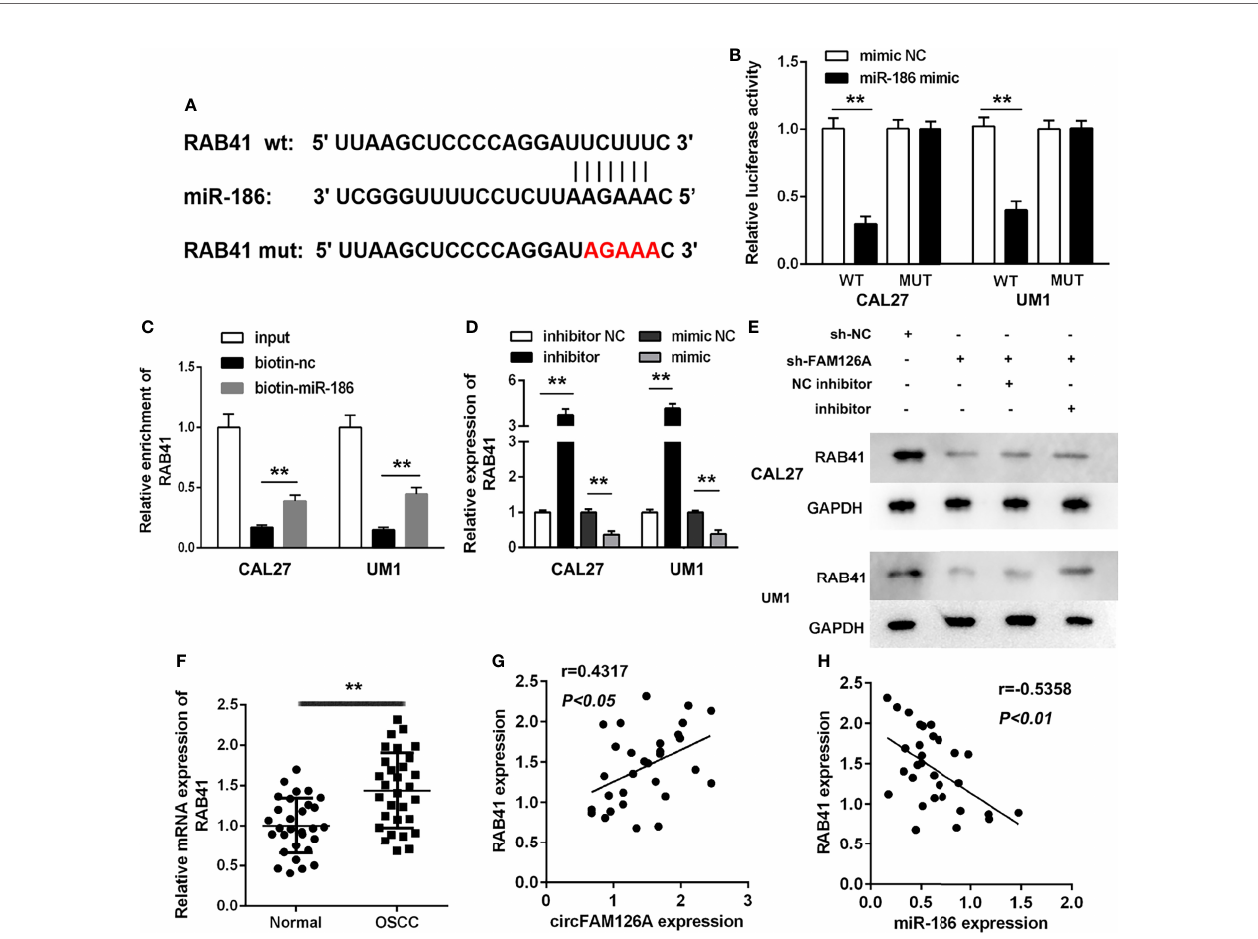
FIGURE 6 | RAB41 is a target of miR-186 in OSCC cells. (A) The binding sites predicted by TargetScan7.2. (B) The binding sites veri fi ed by dual-luciferase reporter assay. (C) The interaction between RAB41 and miR-186 determined by RNA pull-down assay. (D) mRNA expression of RAB41 in OSCC cells detected using qRT- PCR. (E) Protein expression of RAB41 in OSCC cells measured using western blot. (F) Expression of RAB41 in OSCC clinical samples determined by qRT-PCR. (G) Correlation analysis of RAB41 and circFAM126A in clinical samples. (H) Correlation analysis of RAB41 and miR-186 in clinical samples. ** P <0.01, ## P